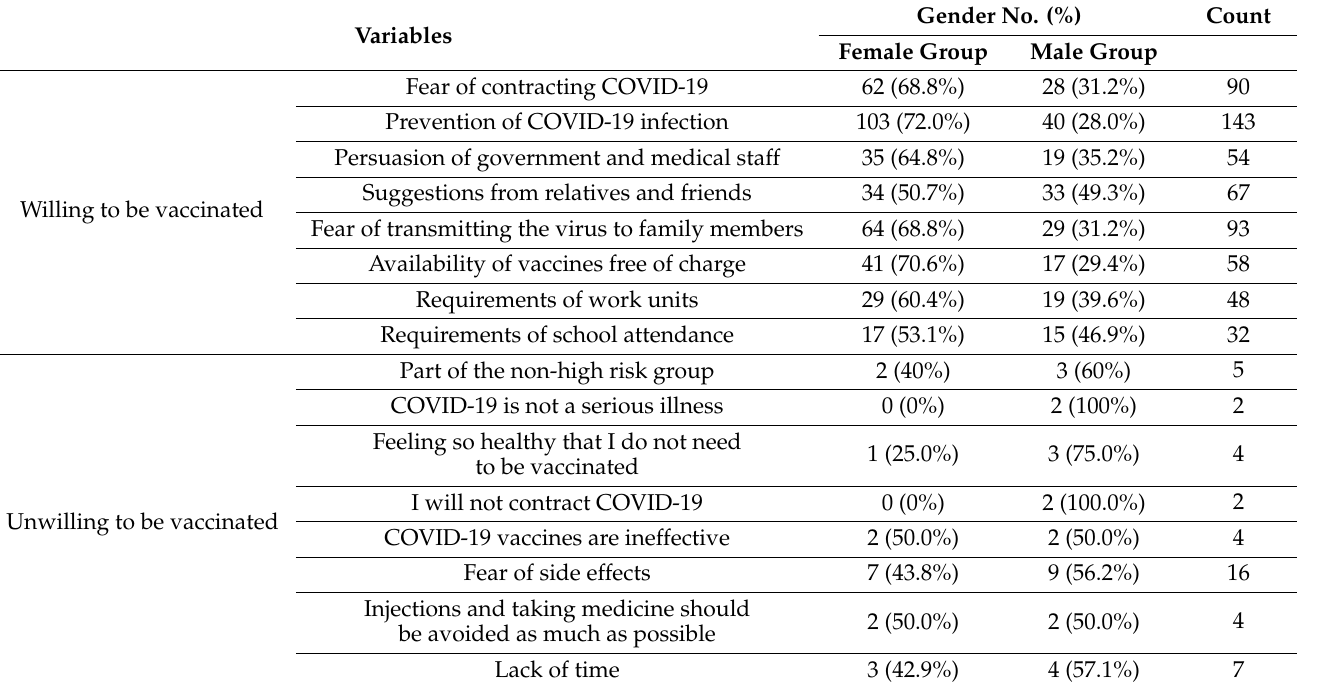
Table 1. Survey on continued vaccination willingness.